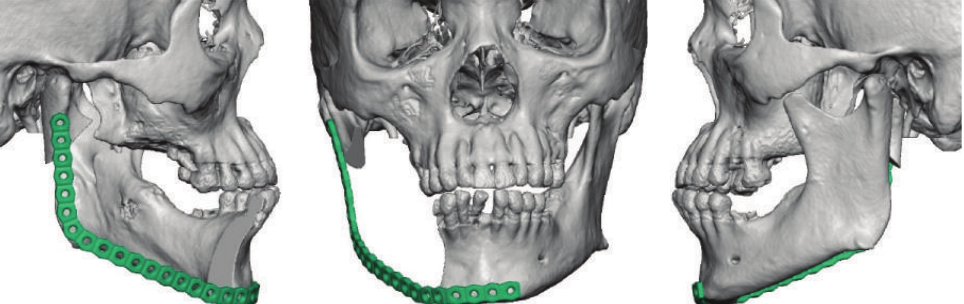
Figure 9: Simulated surgical